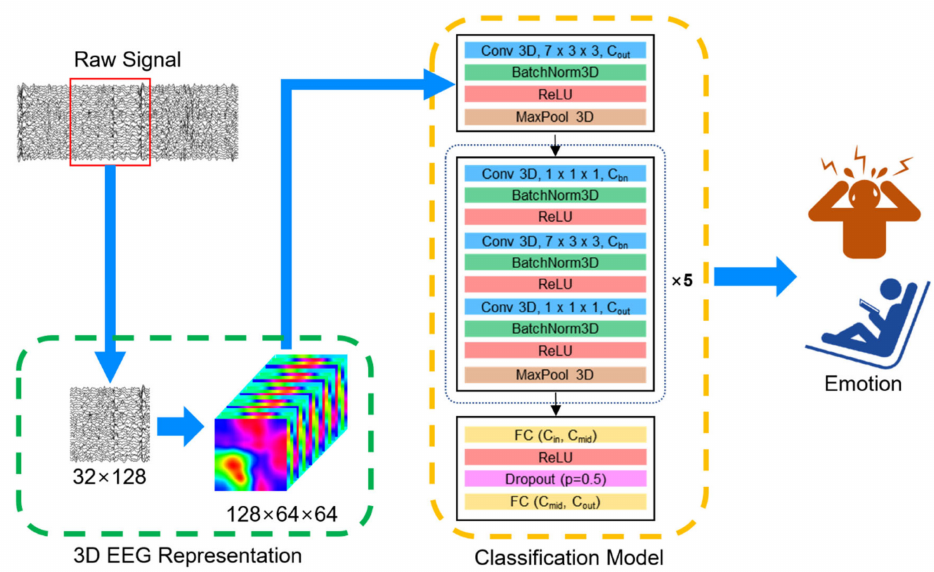
Figure 1. Overview of the workflow for EEG-based emotion recognition. 3D representation of EEG signals is constructed as the input of our proposed CNN-BN model. The model consists of a convolutional block, five consecutive bottleneck blocks, and a dense block for EEG-based